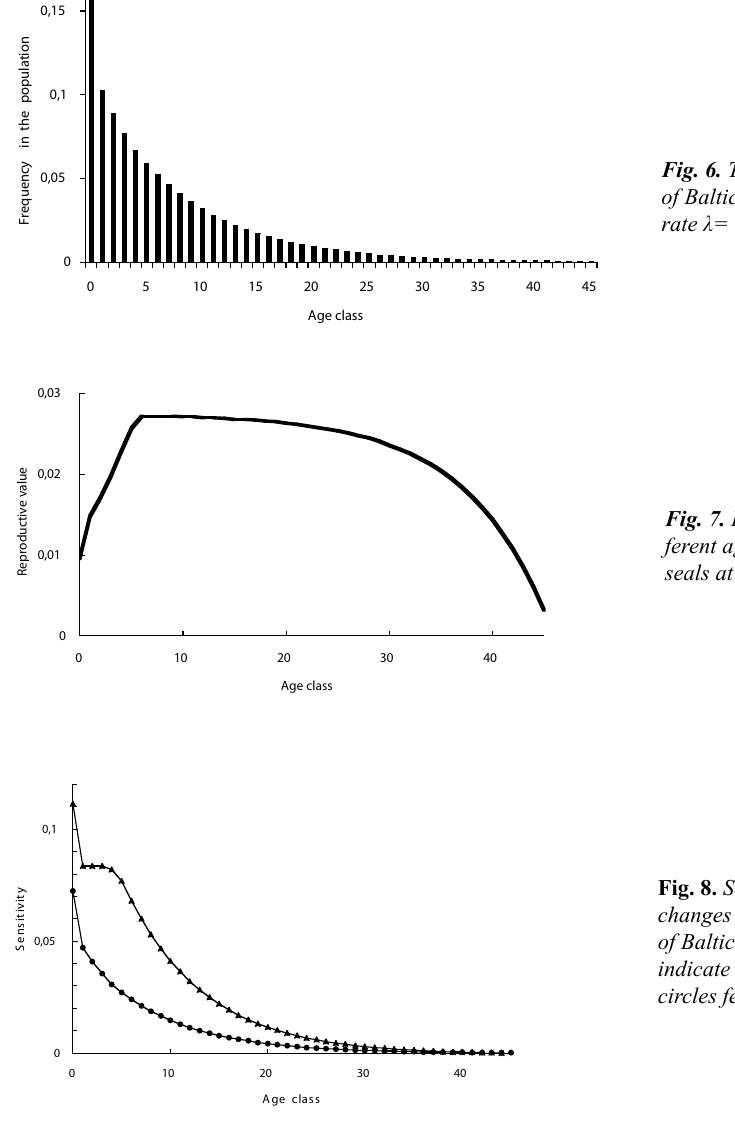
Fig. 6. The stable age distribution of Baltic grey seals at the growth rate λ= 1.075.